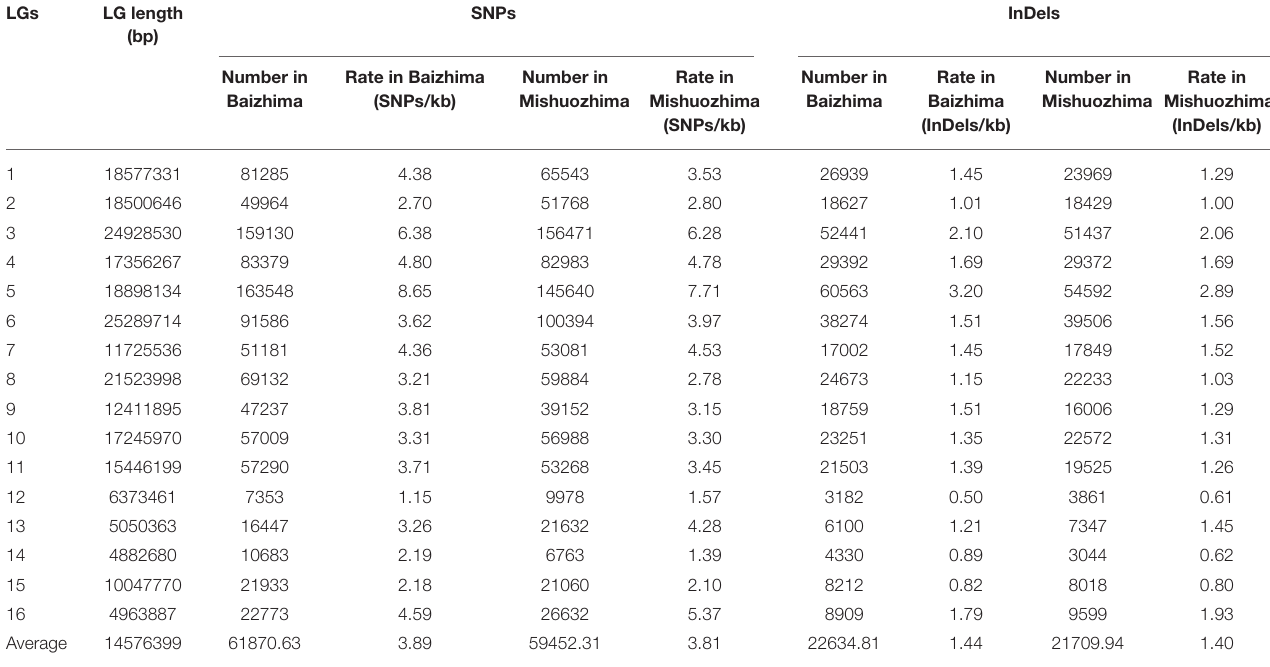
TABLE 2 | Summary of SNPs and InDels rate in LGs of sesame genome.